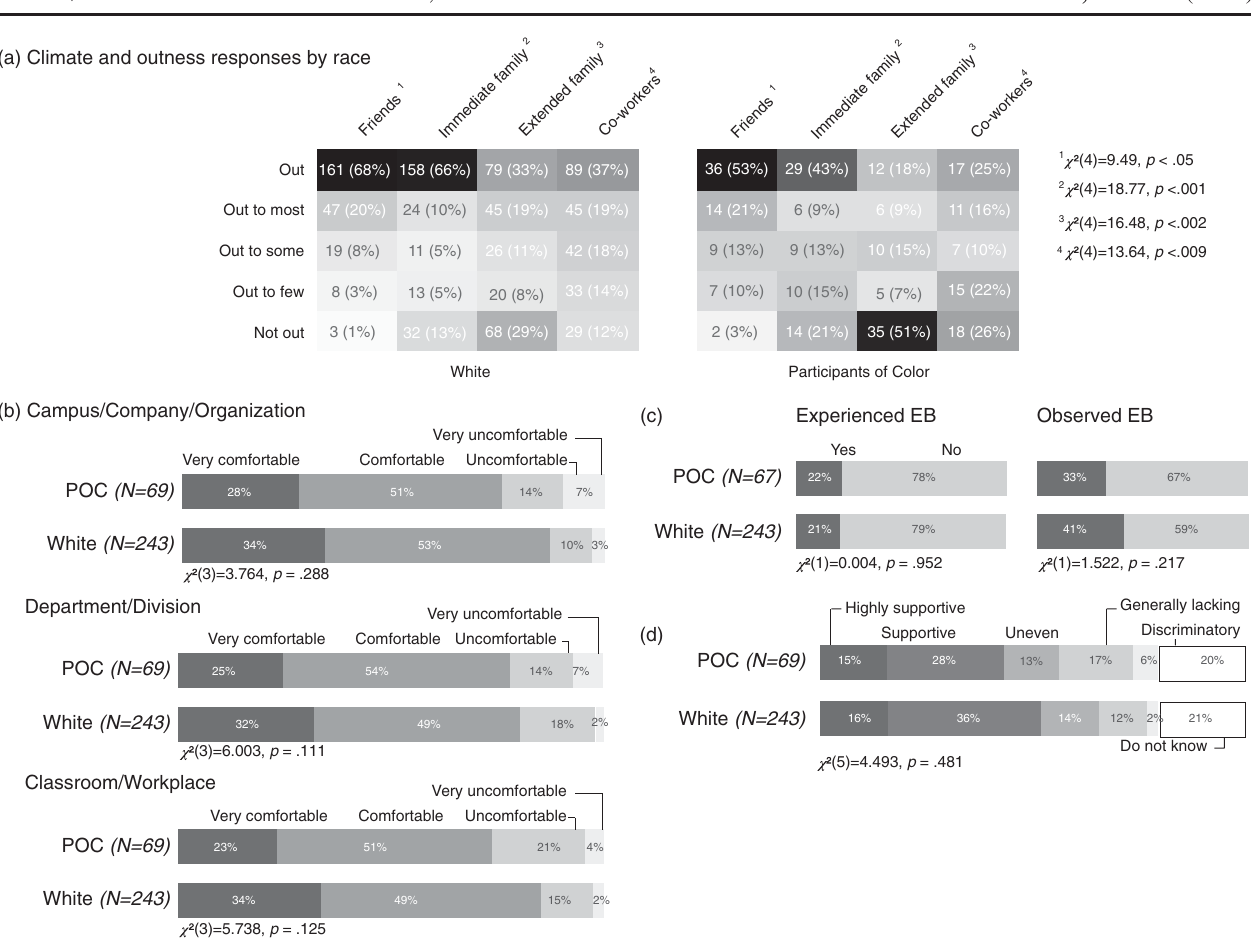
FIG. 6. Survey data disaggregated into white participants and Participants of